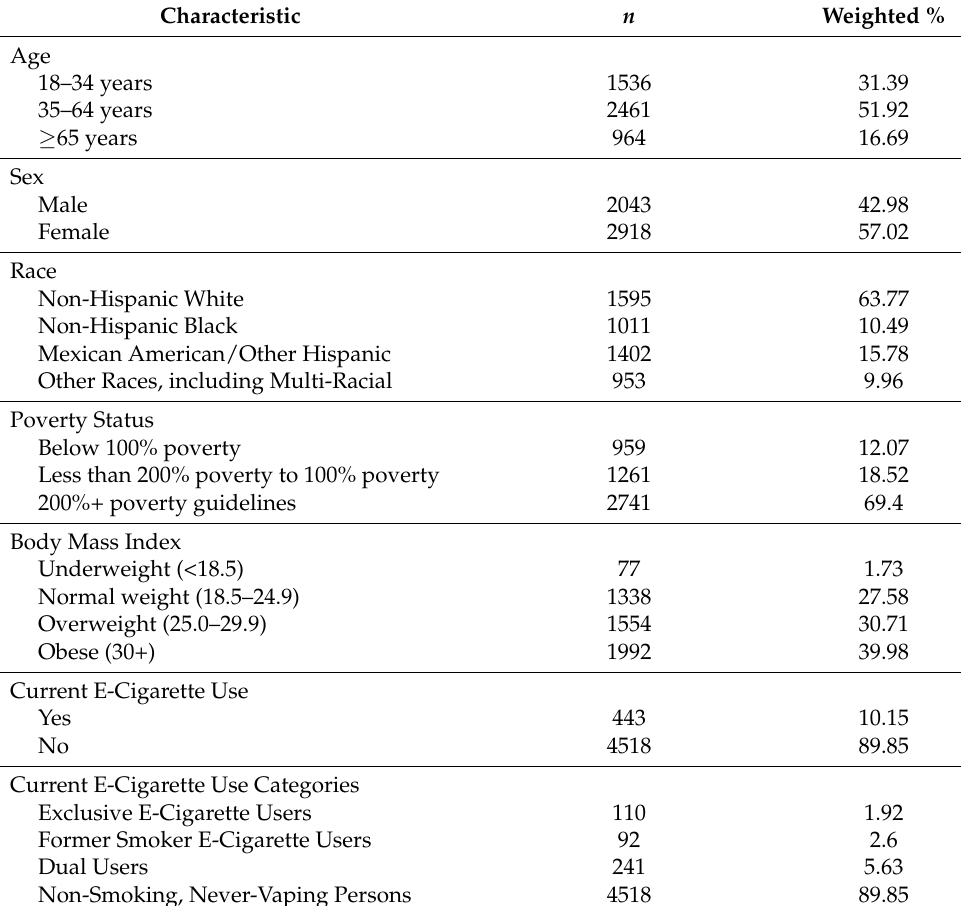
Table 1. Characteristics of the NHANES 2015–2016 & 2017–2018 Study Population ( n =